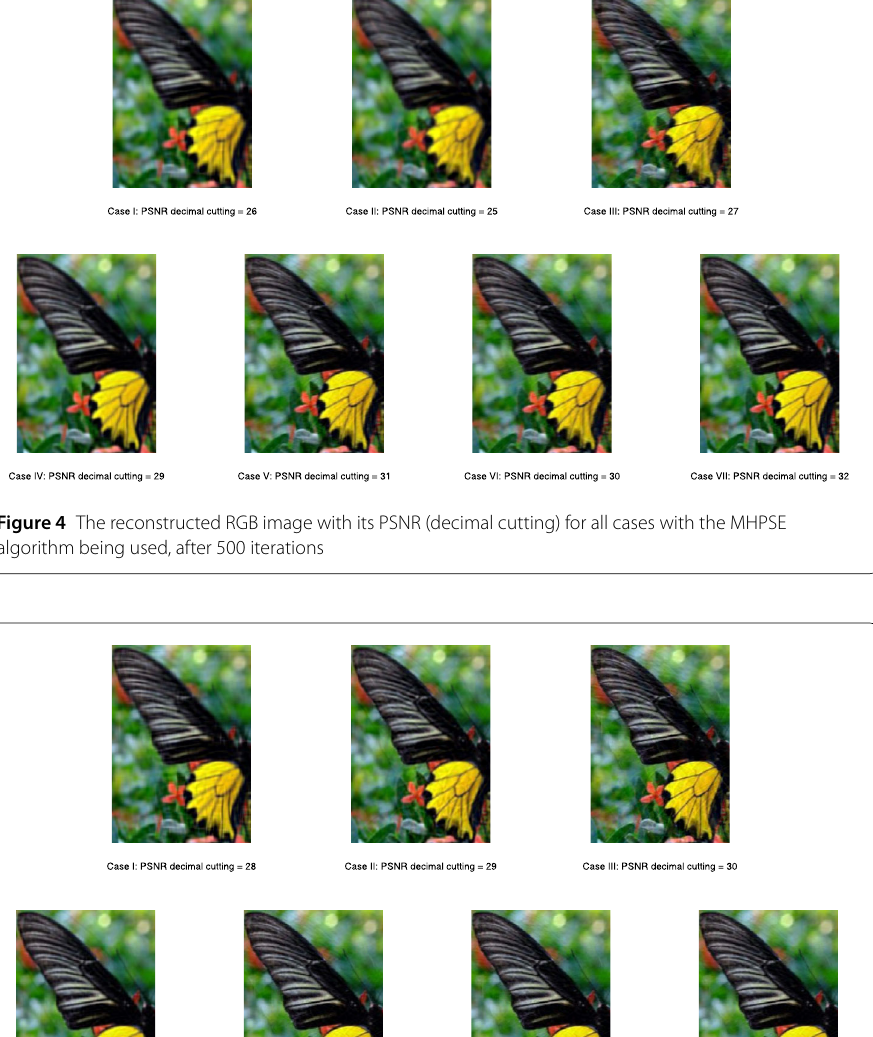
covered RGB image. Moreover, it has been found that the recovered RGB image